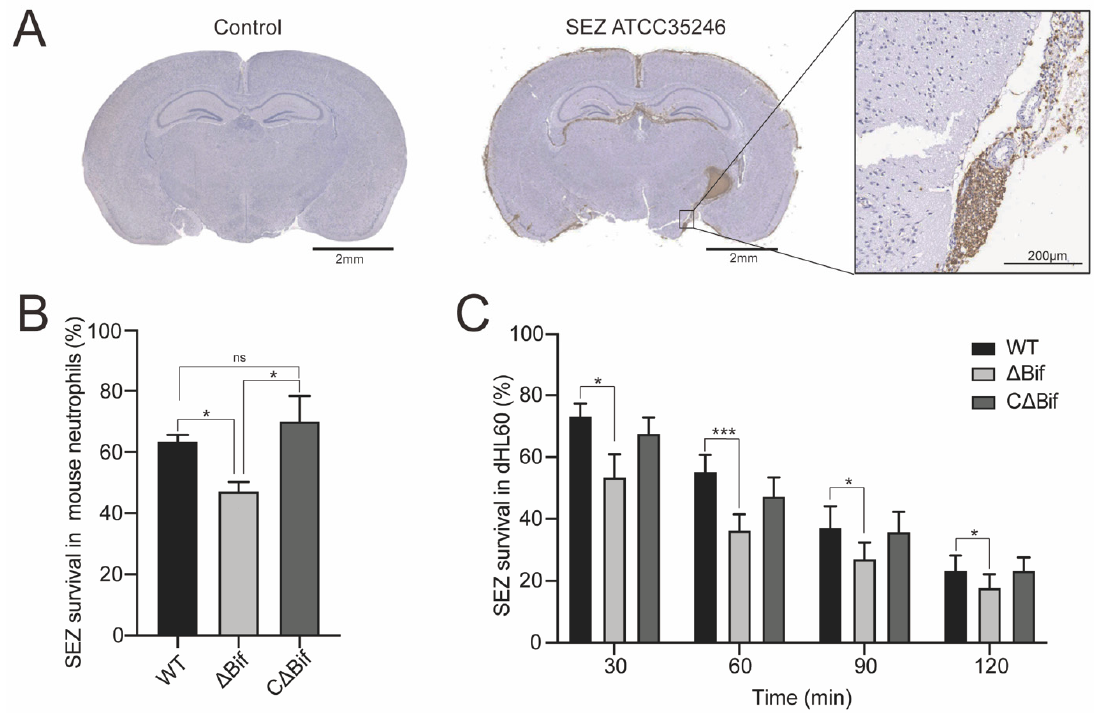
Figure 1. The bifA gene defective SEZ strain is more susceptible to neutrophils killing. ( A ) SPF BALB/c mice were challenged with 1 × 10 6 CFU wild-type SEZ (SEZ ATCC 35246) or PBS as a control. Brains were stained with immunohistochemistry after the paraffin section. Granulocytes, especially the neutrophils, were stained densely. Severe neutrophils infiltration happened in SEZ infected mouse brain. ( B ) The survival percentage of SEZ, Δ Bif and C Δ Bif after engaging with primary mouse neutrophils (multiplicity of infection, MOI = 1:10) for 60 min in vitro ( n = 3, p values were calculated with one-way ANOVA, * indicates p < 0.05; ns indicates no significant difference) ( C ) The survival percentage of SEZ, Δ Bif and C Δ Bif in dHL60 cells at different time points ( n = 6, p values were calculated with one-way ANOVA for each time point, * indicates p < 0.05; *** indicates p < 0.001). 3.2. BifA Can Interact with Ezrin in Neutrophils and Elevate the p-Ezrin Level in PKC- Dependent Manner BifA has been identified as an important virulent factor in blood-brain barrier pene- tration of SEZ ATCC35246 via interacting with moesin in endothelium cells. However, it is still unknown whether BifA could bind to other ERM family proteins in other cell types. Since BifA was responsible for neutrophils killing tolerance in vitro, we localized the ezrin and exogenous BifA protein in neutrophils. Interestingly, in the BifA treated dHL60 cells, p-ezrin and BifA were co-localized in the cytoplasm (Figure 2A). Negative control (NC) was purified parallel with BifA but from BL21 harboring empty plasmid used as backbone vector for BifA protein expression. The NC-treated neutrophils did not have as luminous p-ezrin signal as the BifA-treated ones, indicating that the BifA treatment might increase the ezrin phosphorylation level in neutrophils. Further experiments supported this pre- sumption. In the first 2 h after BifA addition in dHL60 cells, the p-ezrin level increased along with time. In contrast, NC-treated dHL60 cells had stable p-ezrin at a low level (Fig- ure 2B). In addition, we detected the ratio of p-ezrin/total-ezrin in dHL60 under BifA treat- ment with the phos-tag assay. The ratio increased from <0.1 to 1, indicating most ezrin was phosphorylated within 2 h (Figure 2C). However, under the treatment of staurospor- ine (an ATP-competitive and non-selective protein kinases inhibitor), BifA-induced ezrin phosphorylation was utterly abrogated, suggesting that PKC played a vital role in ezrin phosphorylation elevation relevant to BifA (Figure 2D). With the Co-IP approach, we